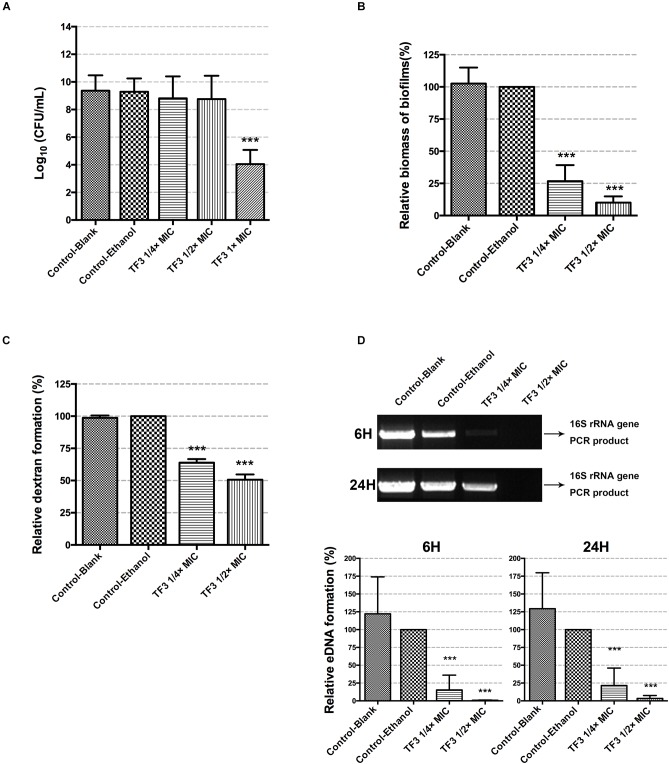
The bactericidal effects of sub-MIC TF3 on S. mutans UA159 were determined by colony counting (A). The effects of TF3 on S. mutans UA159 biofilm formation were detected by crystal violet staining and OD595 measurements. Data shown is relative biomass of biofilms compared with the control-ethanol group (B). Dextran formation of S. mutans UA159 was detected by measuring the fluorescence excited by a Cascade Blue-conjugated dextran dye. Data shown is relative dextran formation compared with the control-ethanol group (C). The eDNA content in biofilms of S. mutans UA159 was semi-quantified by PCR using primers for the 16S rRNA gene. The PCR products were imaged using an ultraviolet camera after electrophoresis on 1% agarose gels and quantified using Image Lab. The full scans of the original gels are shown in Supplementary Figure 5. Data shown is relative eDNA formation compared with the control-ethanol group (D). The results are shown as the mean and standard deviation of three independent experiments. ∗∗∗P < 0.001, when compared with the control-ethanol group using one-way ANOVA.